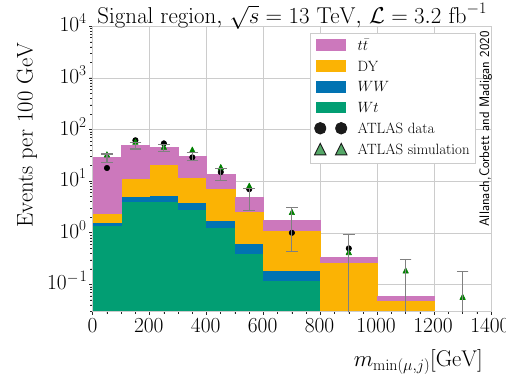
Fig. 9 Validation plot showing our simulations of the m min (μ, j ) dis- tribution of the SM backgrounds in the search for the pair production of second generation LQs in the μμ jj channel at fb − 1 in the signal region. We compare our simulations to the ATLAS simulations and data for validation